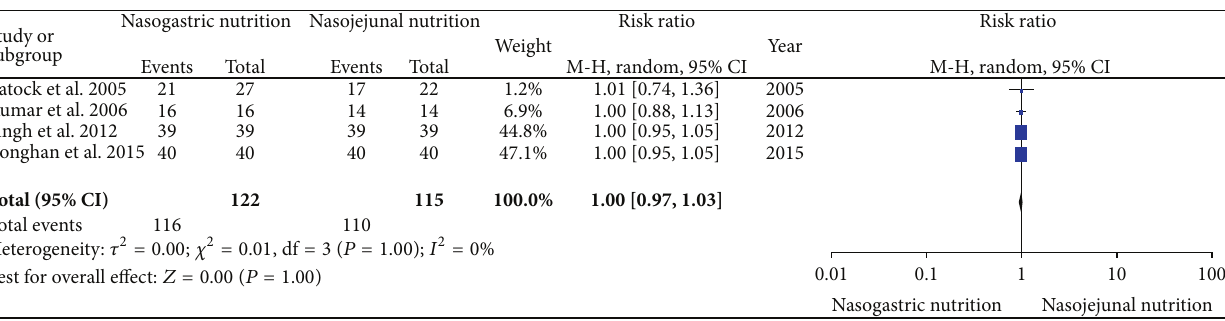
Figure 6: Comparison of the achievement of energy balance between the NG and NJ nutrition groups.